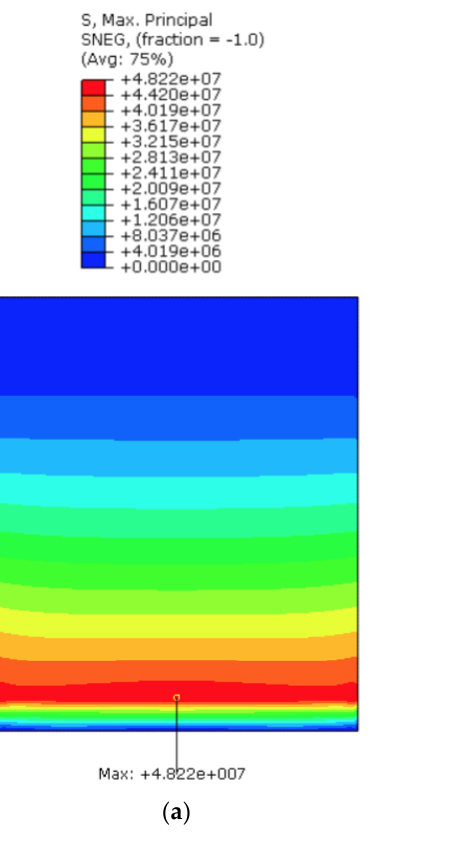
Figure 17. Numerical analysis of the principal stress distribution and peaks in glass for the ( a ) SM3 (translational springs) and ( b ) SM4 (rotational springs) simplified models (ABAQUS) under double twin-tyre impact (300 mm being the drop height), with legend values in Pa.